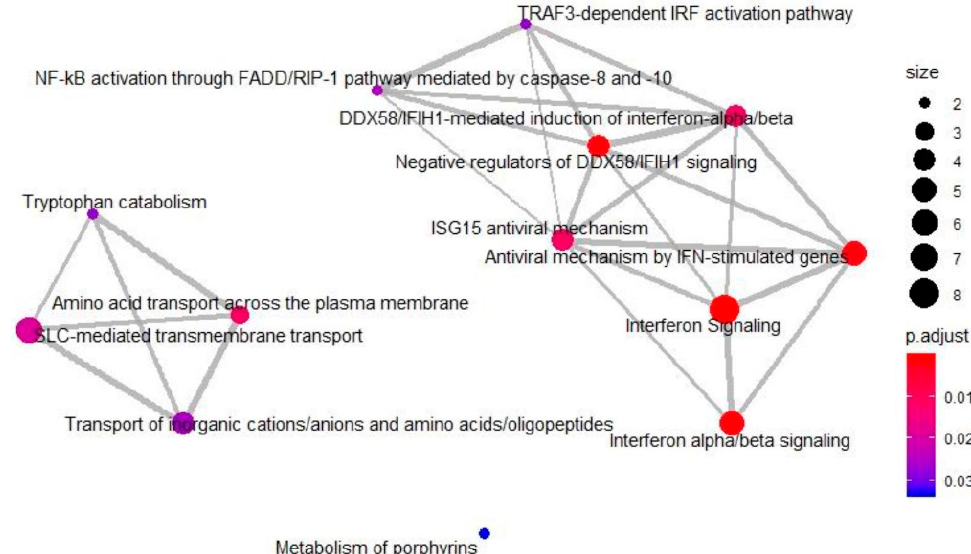
Figure 3. Reactome pathway enrichment map for downregulated proteins in oxaliplatin-resistant PANC-1 cells. The node color indicates significance of the reactome pathway and the node size represents the number of genes in the reactome pathway.